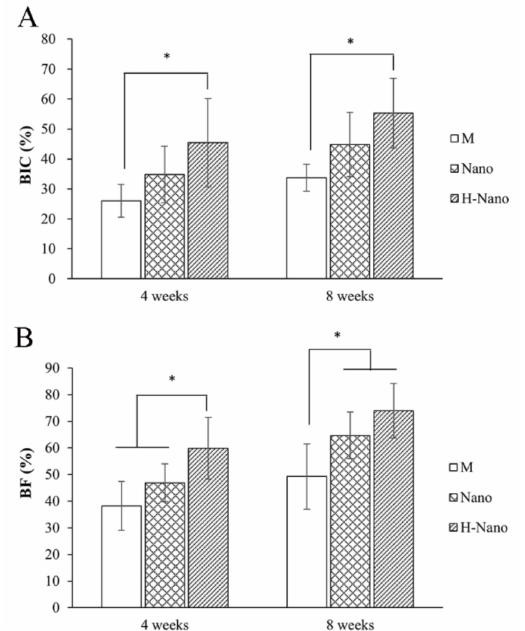
Figure 6. Quantification of ( A ) the bone–implant contact (BIC%) and ( B ) bone fraction (BF%) in the histological samples. * p <